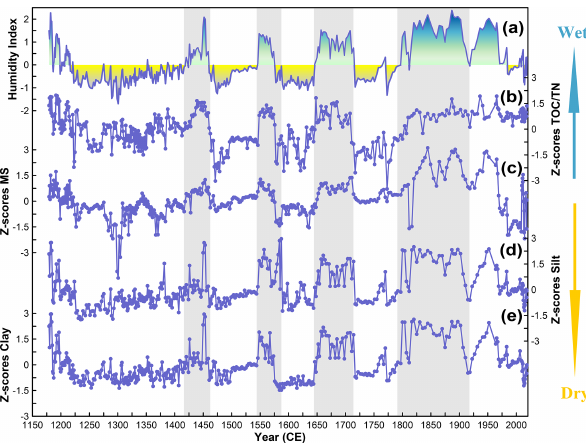
to a Z score (Fig. 5b, c, d, e). Then the HI was derived from the average of the normalized standard Z scores. Positive and (Fig.